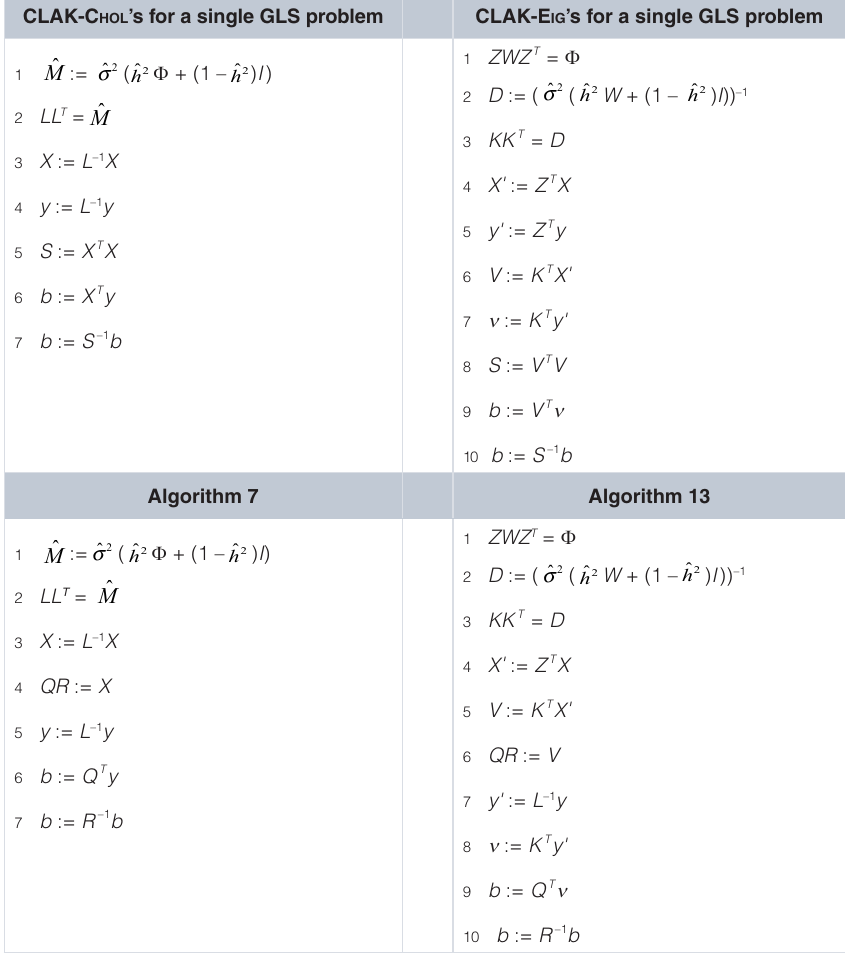
Table S2. Representative list of algorithms for solving a single generalized least-squares problem, as generated by the CLAK expert system.